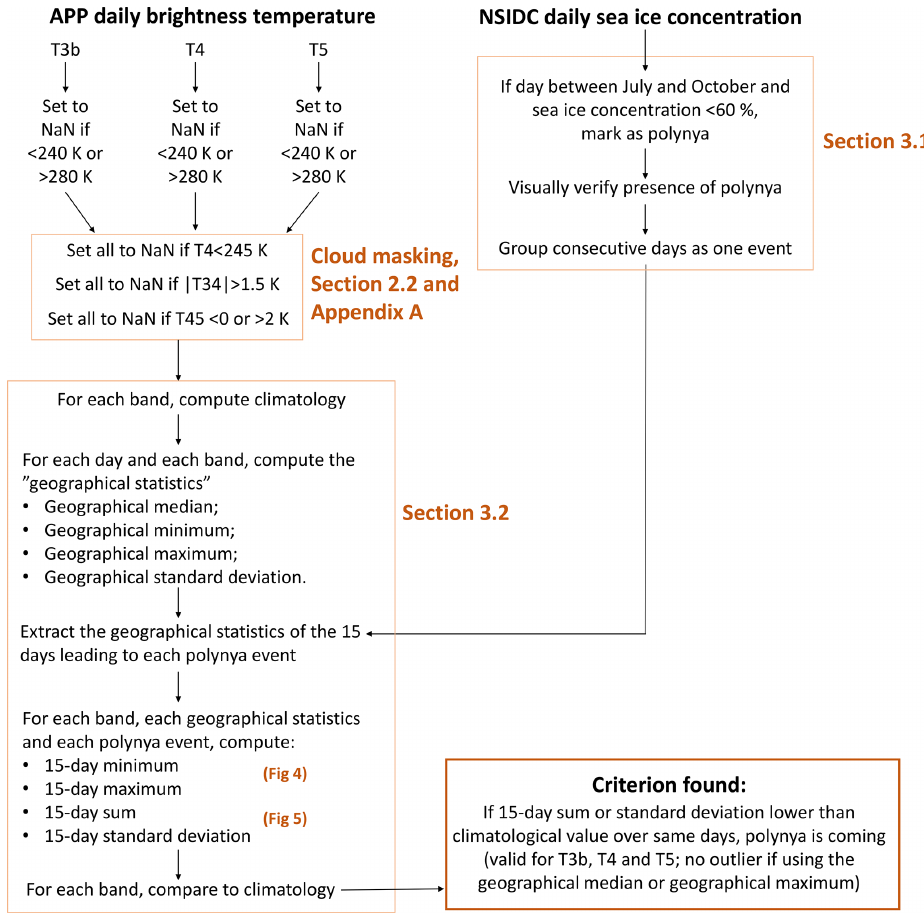
Figure 6. Flow chart summarising our methods and the findings of Sect.